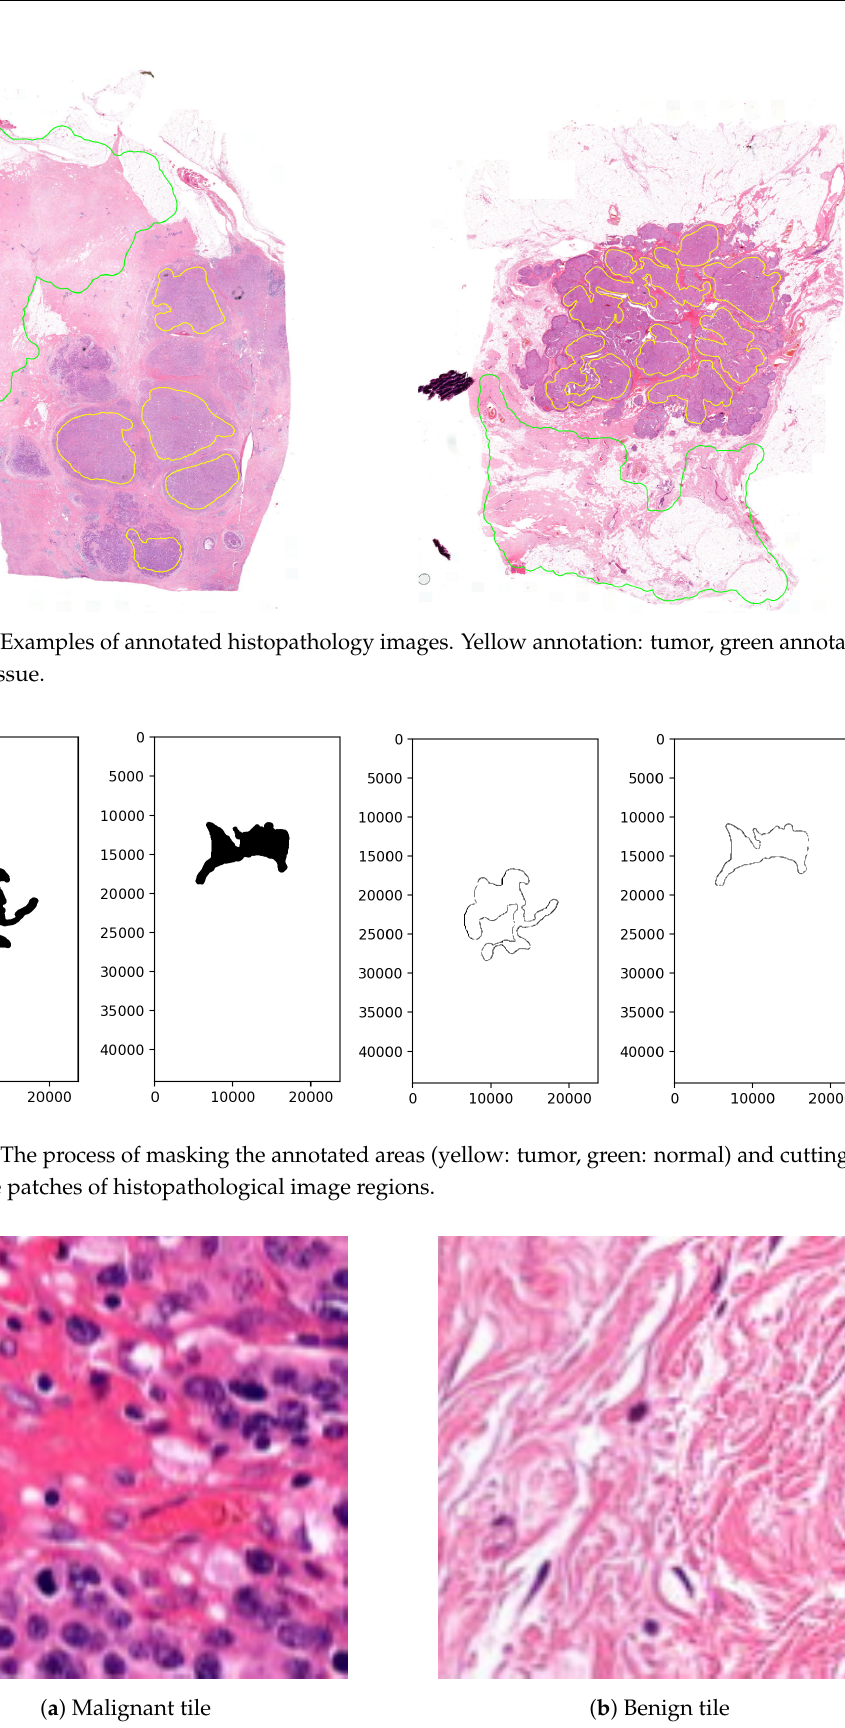
Figure 4. Examples of 128 × 128-pixel resolution annotated histopathological image